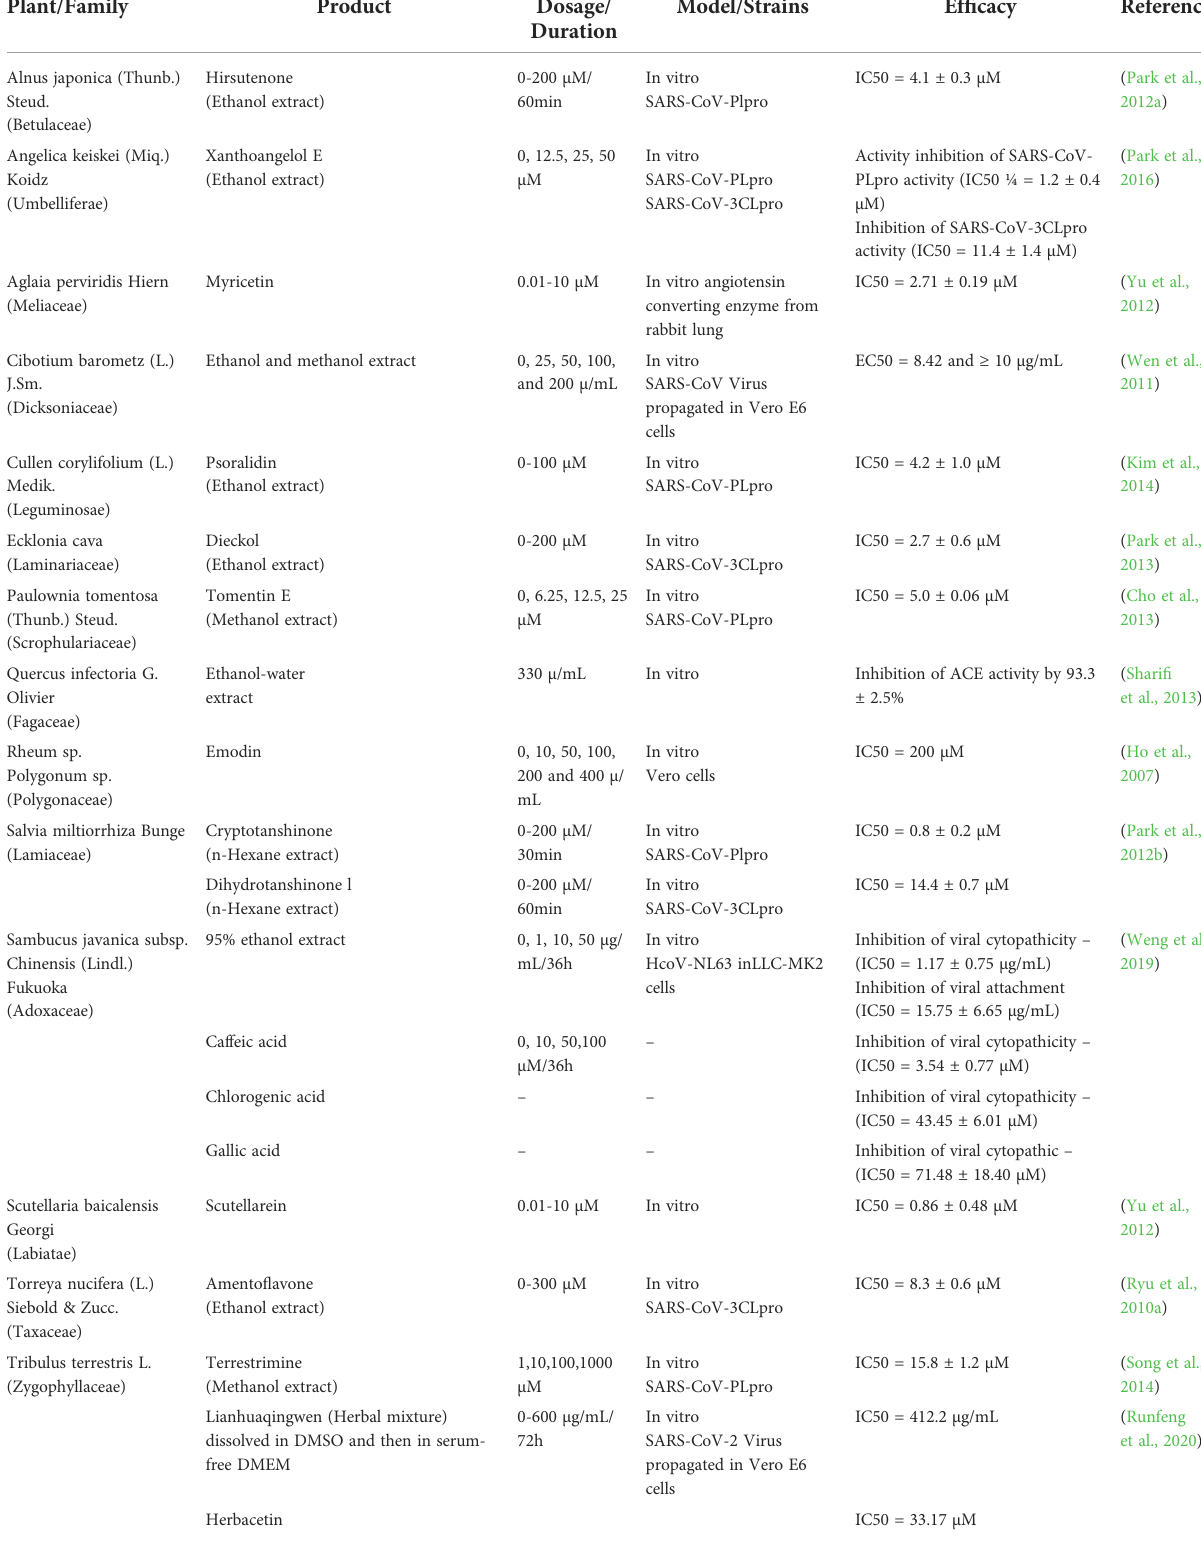
TABLE 1 List of compounds derived from natural sources that are potential anti-COVID-19 drug candidates (Prasansuklab et al., 2020).